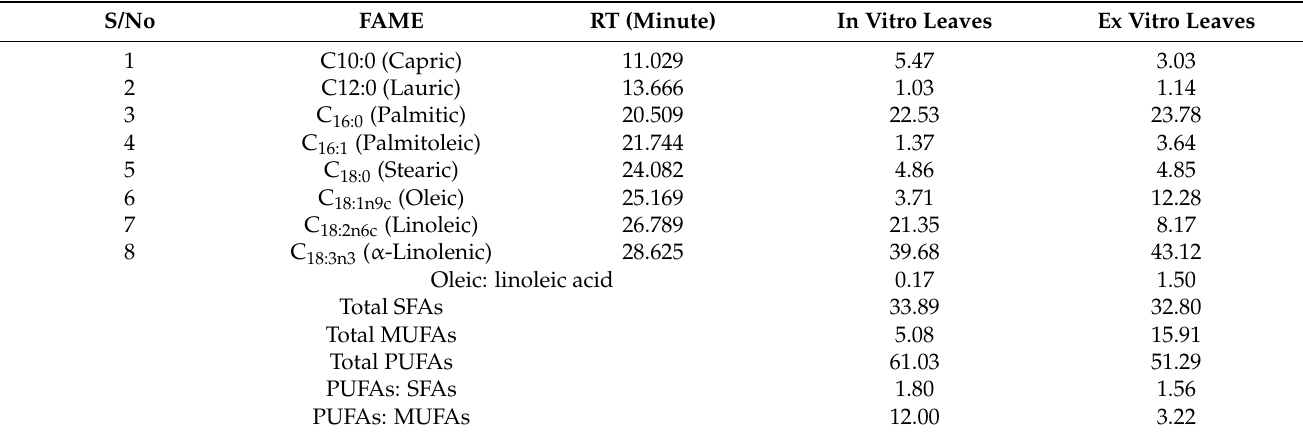
Figure 3. GC–FID chromatograms of FAMEs of KP-BG leaves. (1) C10:0 (Capric), (2) C12:0 (Lauric), (3) C16:0 (Palmitic), (4) C16:1 (Palmitoleic), (5) C18:0 (Stearic), (6) C18:1n9c (Oleic), (7) C18:2n6c (Linoleic), (8) C18:3n3 ( α -Linolenic). Table 2. Composition of fatty acids in KP-BG leaves.